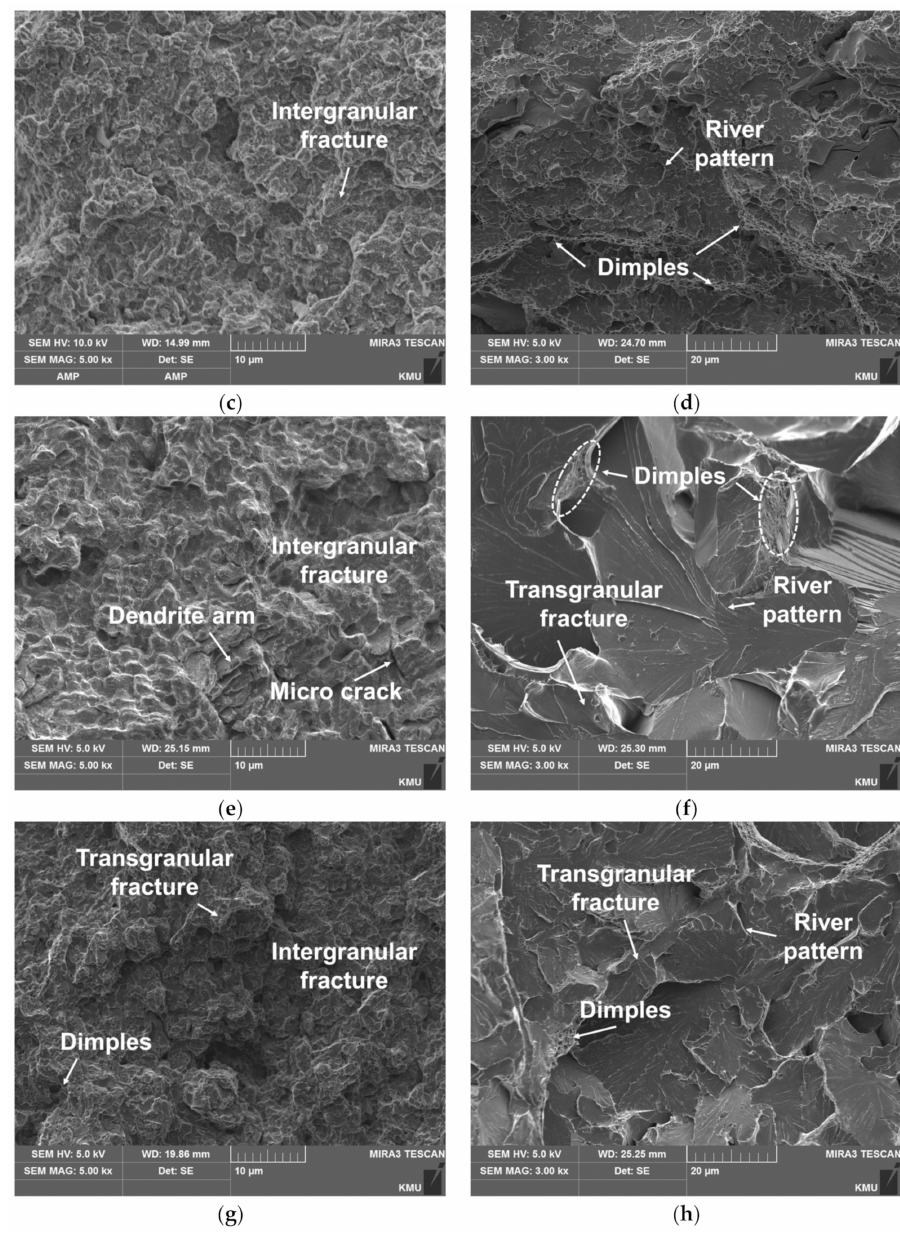
Figure 14. Micro-images of the fracture surfaces: ( a ) carburized layer of SCM420, ( b ) center region of C-SCM420, ( c ) de- posited layer of as-built (M2), ( d ) interface of as-built (M2), ( e ) deposited layer of as-built (FeCrVMoW), ( f ) interface of as-built (FeCrVMoW), ( g ) deposited layer of as-built (FeCrVMoW)-PHT and ( h ) interface of as-built